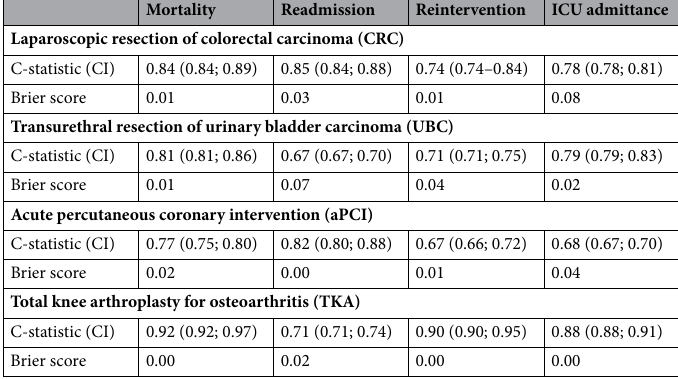
Table 7. Model fit statistics and brier score for dichotomous outcomes.